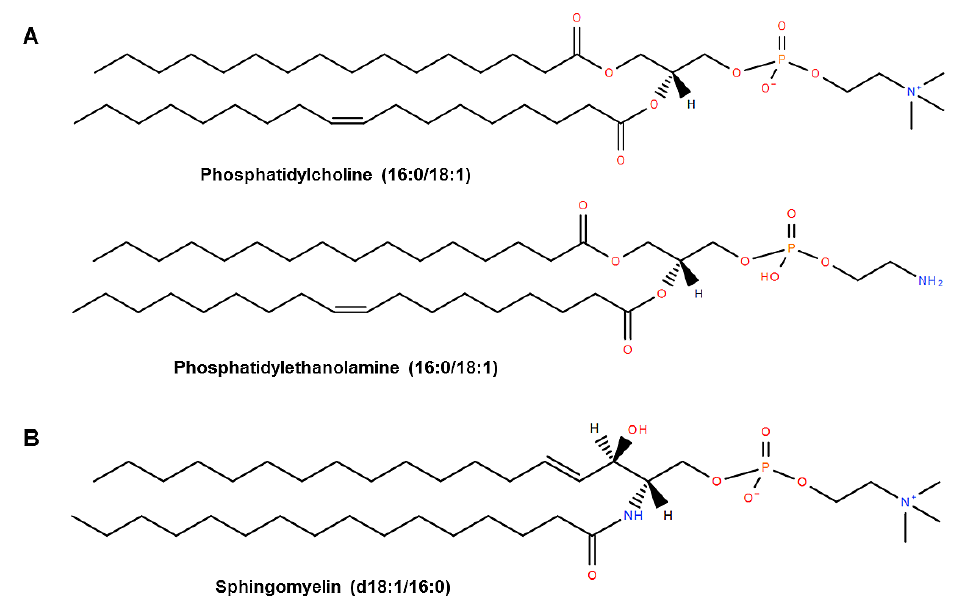
Figure 1. Structures of major phospholipids in egg yolk. Major molecular species of egg glycerophospholipids ( A ) and sphingomyelin ( B ). Lipid structures were drawn using Lipid MAPS tools